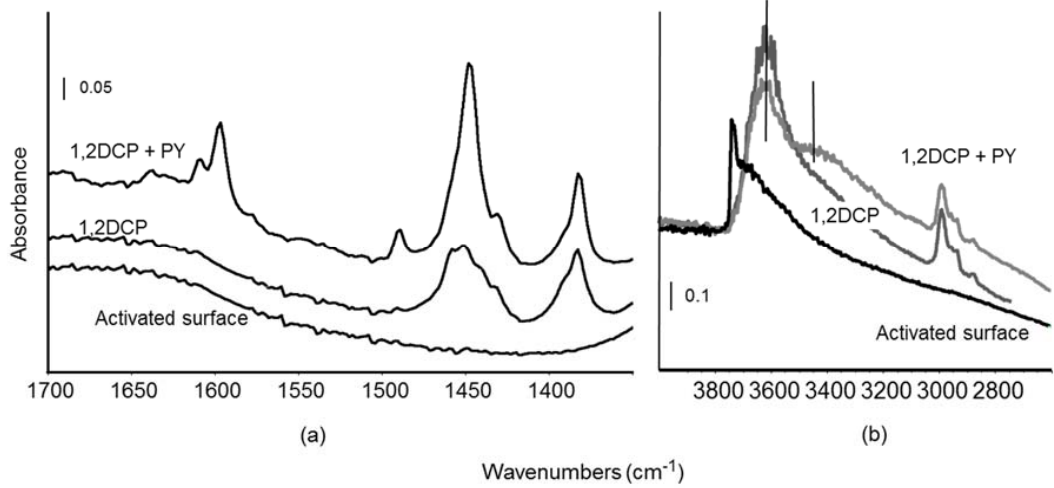
Figure 3. FT ‐ IR spectra of surface species arising from 1,2DCP adsorption and heating at 50 °C and pyridine ‐ 1,2DCP coadsorption over the fresh 30Co/SBA catalyst ( a ); High frequency region ( b ).